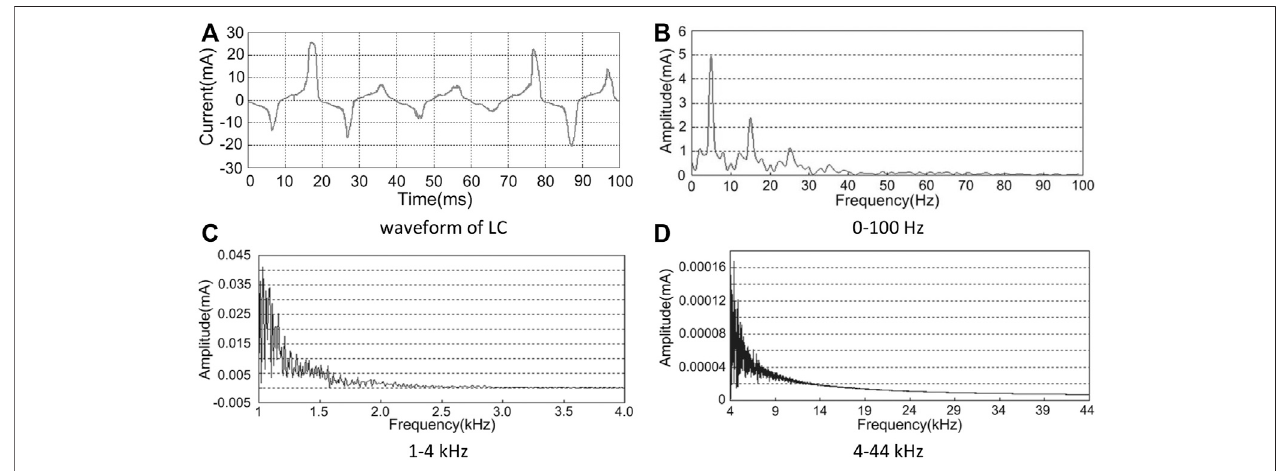
FIGURE 3 | The LC waveform and its Fourier